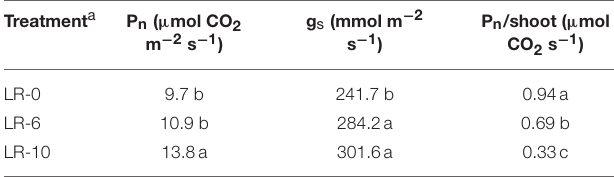
TABLE 3 | Impact of early leaf removal on leaf assimilation (P n ) and stomatal conductance (g s ), at 6 days after full bloom and leaf removal. Treatment